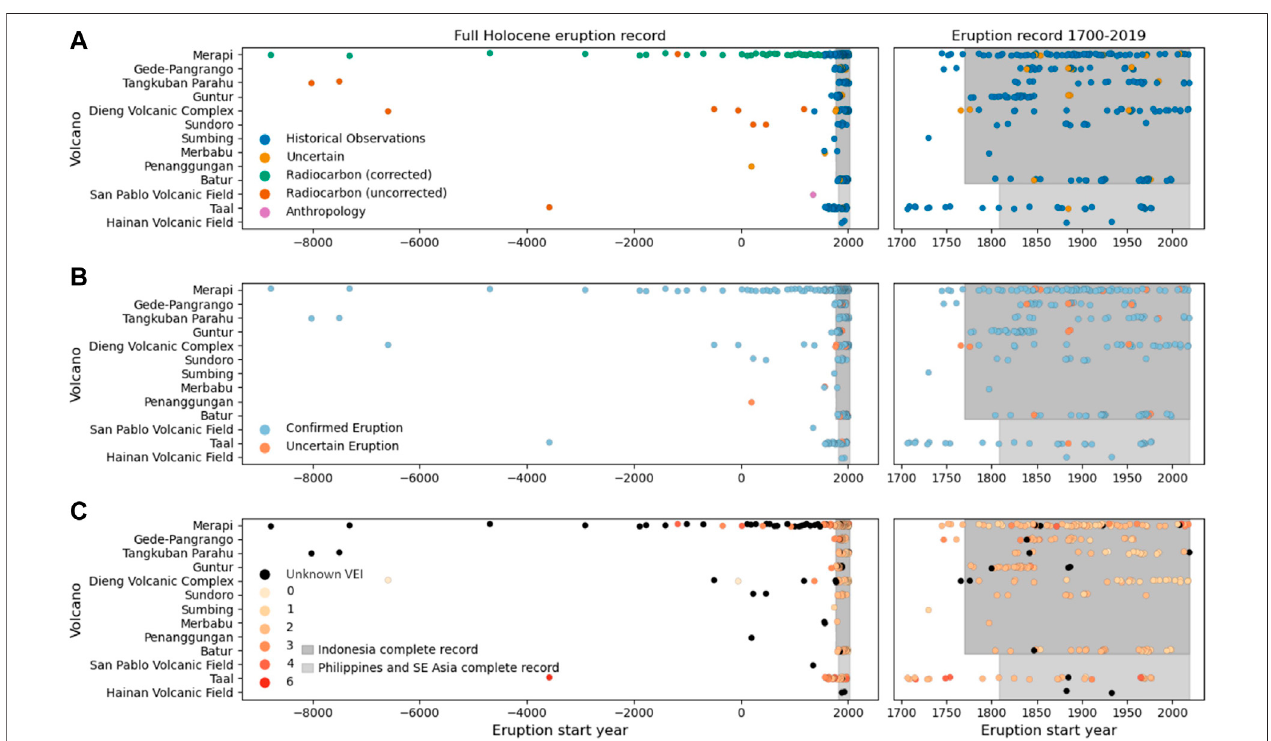
FIGURE 7 | Volcanic eruption records for volcanoes with eruptions within the Holocene volcano catalogue. (A) underlying data type used to inform the eruption record as assigned by GVP, (B) the eruption certainty classi fi cation as assigned by GVP, and (C) VEI classi fi cation. All eruption data from GVP (2013), Complete record data for all VEI eruptions from Mead and Magill